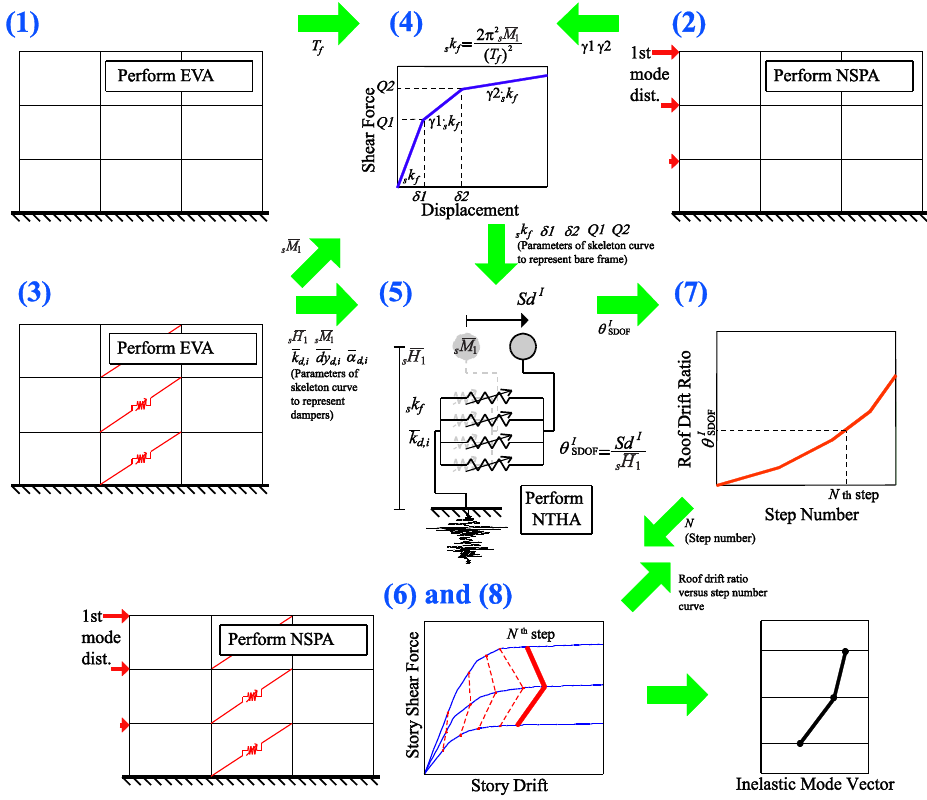
Figure 3. Procedure for estimating the inelastic spectral displacement I Sd and the inelastic mode vector I i  . vector φ I i